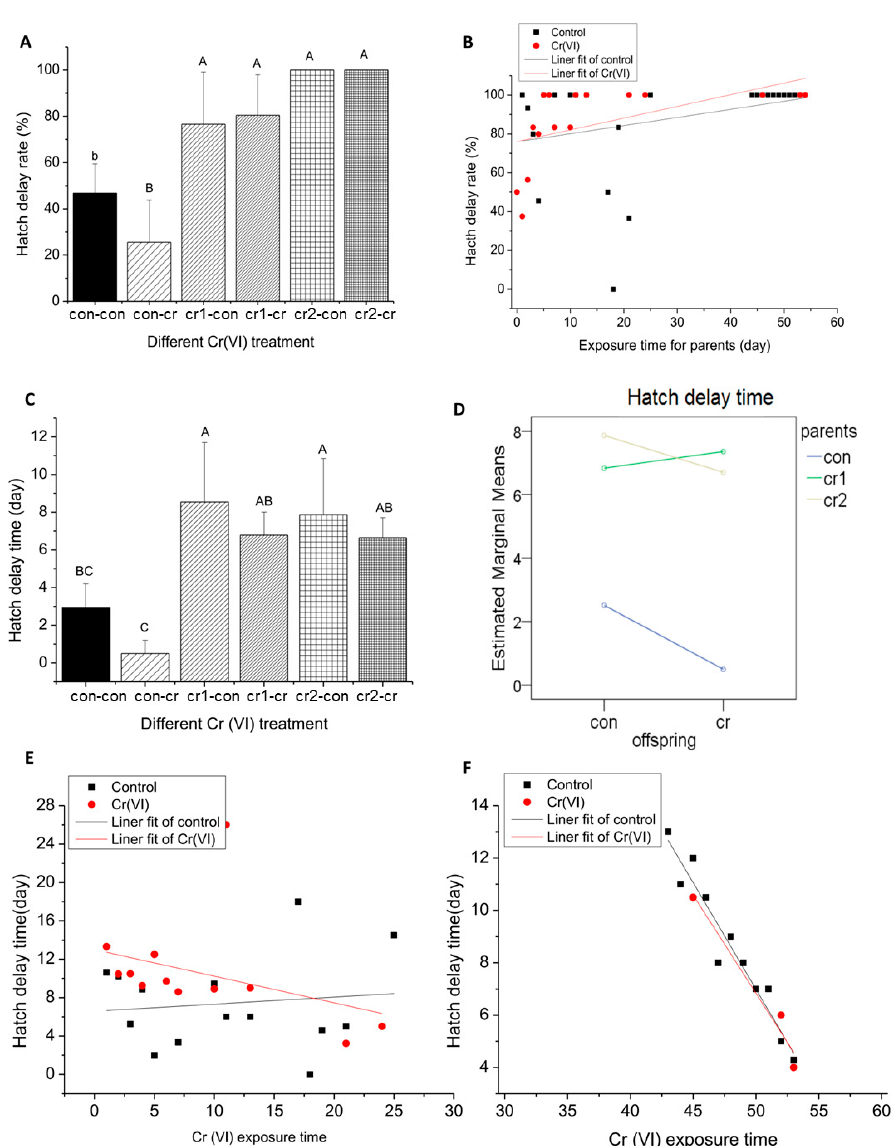
Figure 9. The hatch delay situation after long-term Cr(VI) exposure in marine medaka offspring. ( A , B ) hatch delay rate; ( A ) the hatch delay rate of offspring under different Cr(VI) treatment, different letter means the significant differences among different treatment (upper letter: p ≤ 0.01, lower letter: p ≤ 0.05); ( B ) the daily hatch delay rate under different offspring Cr(VI) exposure after parental Cr(VI) exposure, X axis represents parental treatment, and Y axis represents daily hatch delay rate, the blank line represents offspring in control environment, the red line represents offspring in Cr(VI) environment; the function relationships between exposure time and hatch delay rate were y = 0.41767x + 75.92824, R 2 = 0.06479 (untreated offspring) and y = 0.60299x + 76.06081, R 2 = 0.2451 (treated offspring); ( C – F ) hatch delay time; ( C ) the hatch delay time of offspring under different Cr(VI) treatment, different upper case means the significant differences among different treatment ( p ≤ 0.01); different letter means the significant differences among different treatment (upper letter: p ≤ 0.01, lower letter: p ≤ 0.05) ( D ) the interaction of parent and offspring Cr(VI) treatment for hatch delay time ( p = 0.028); ( C , D ), daily hatch delay time under different offspring Cr(VI) exposure after parental Cr(VI) exposure; ( E ) parental Cr(VI) exposure for first month, the function relationships between exposure time and hatch delay time were y = 007303x + 6.60125, R 2 = − 0.0685 (untreated offspring) and y = − 0.27692x + 13.00838, R 2 = 0.04457 (treated offspring); ( F ) parental Cr(VI) exposure for 2nd month, the function relationships between exposure time and hatch rate were y = − 0.81409x + 47.69364, R 2 = 0.92974 (untreated offspring) and y = − 0.75x + 44.33333, R 2 = 0.92857 (treated offspring). The number of biological samples used for each group is as follow: con-con ( N = 297), con-cr ( N = 34), cr1-con ( N = 70), cr1-cr ( N = 70), cr2-con ( N = 28), cr2-cr ( N =